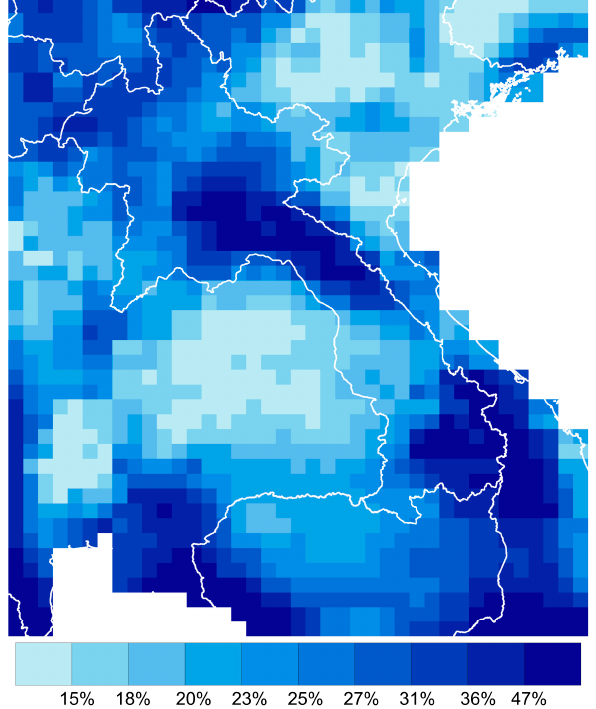
Figure 6. Ratio between estimated median annual recharge ( Q B estim ) and median annual rainfall ( Rain ) in the Lower Mekong Basin.